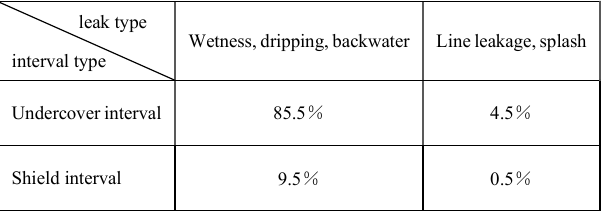
Table 1. Statistical table of water leakage types in the tunnel